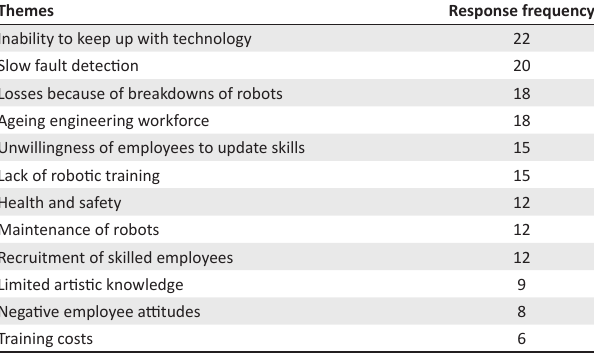
TABLE 3: Challenges faced by automotive organisations with the introduction of robots. Themes Response